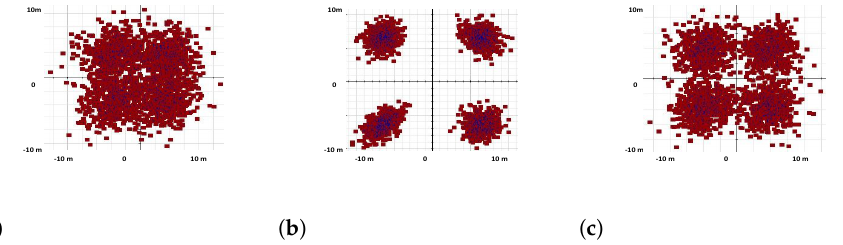
Figure 9. Constellation-diagrams; ( a ) constellation visualizer outputs with conventional laser, ( b ) con- stellation visualizer results using ML-based VCSEL, and ( c ) constellation visualizer outcomes using simple